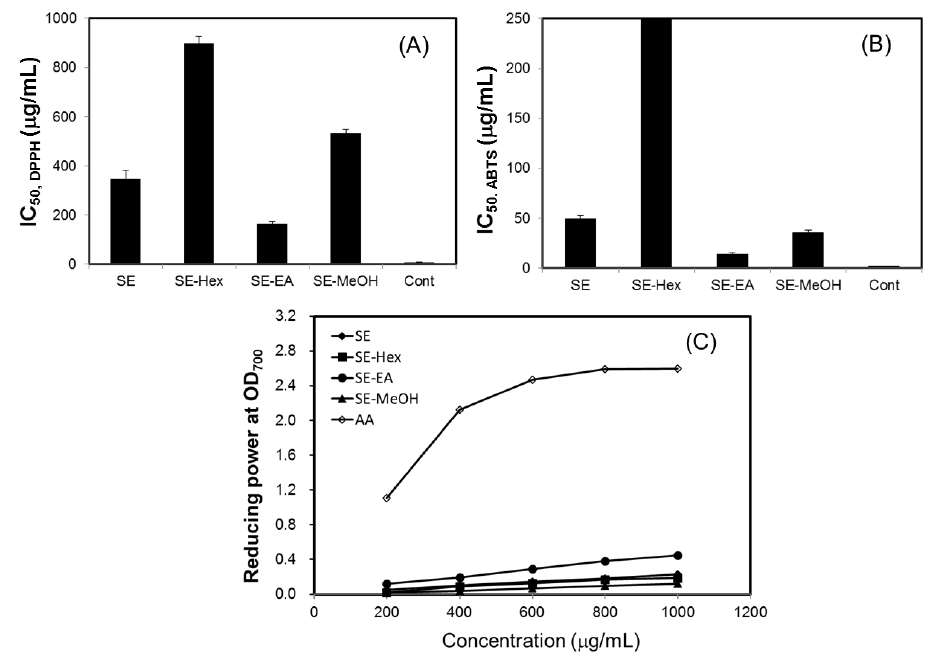
Figure 2. Antioxidant activity of S. orientalis extracts. ( A ) DPPH radical scavenging activity (expressed by IC 50 values), catechin was used as the positive control; ( B ) ABTS radical cation scavenging activity (expressed by IC 50 values), BHT was used as the positive control; ( C ) Reducing power, ascorbic acid (AA) was used as the positive control.